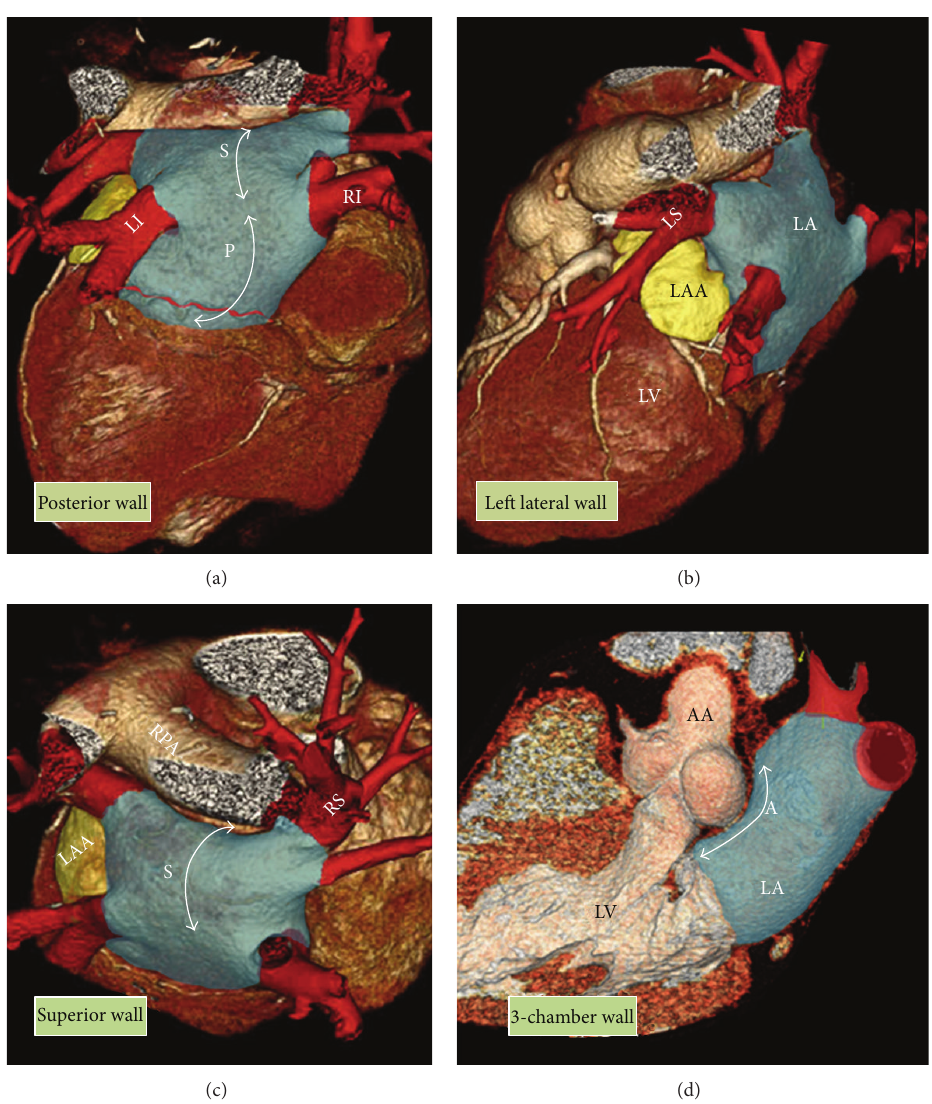
Figure 3: Anatomic relationship of the left atrium (LA). Posterior, right lateral, superior, and three-chamber view of volume rendered CT angiographies are shown. The LA (in blue) is located superiorly and posteriorly to the heart. The walls of LA include the anterior, superior, left lateral, septal, and posterior. Its superior (S) and posterior (P) walls are shown by double-headed arrows. Note close relation of the anterior (A) wall to the ascending aorta (AA). The left atrial appendage (LAA) is shown in yellow and the pulmonary veins are shown in red. The four pulmonary veins include LS = left superior, LI = left inferior, RS = right superior, RI = right inferior, LV = left ventricle.